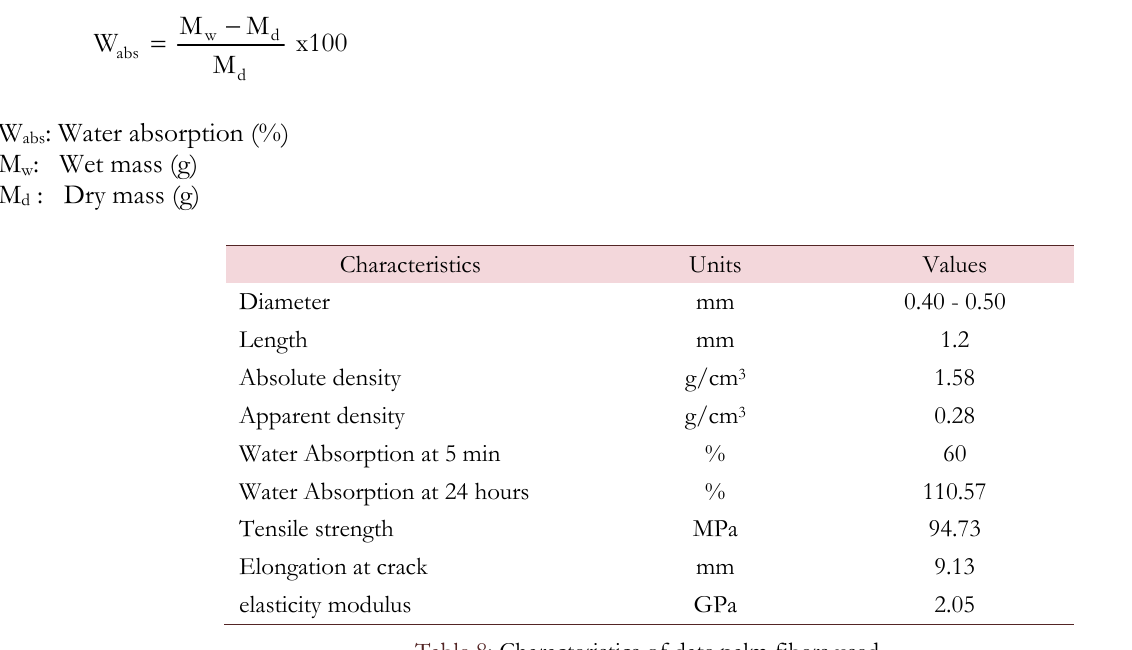
Table 8: Characteristics of date palm fibers used.